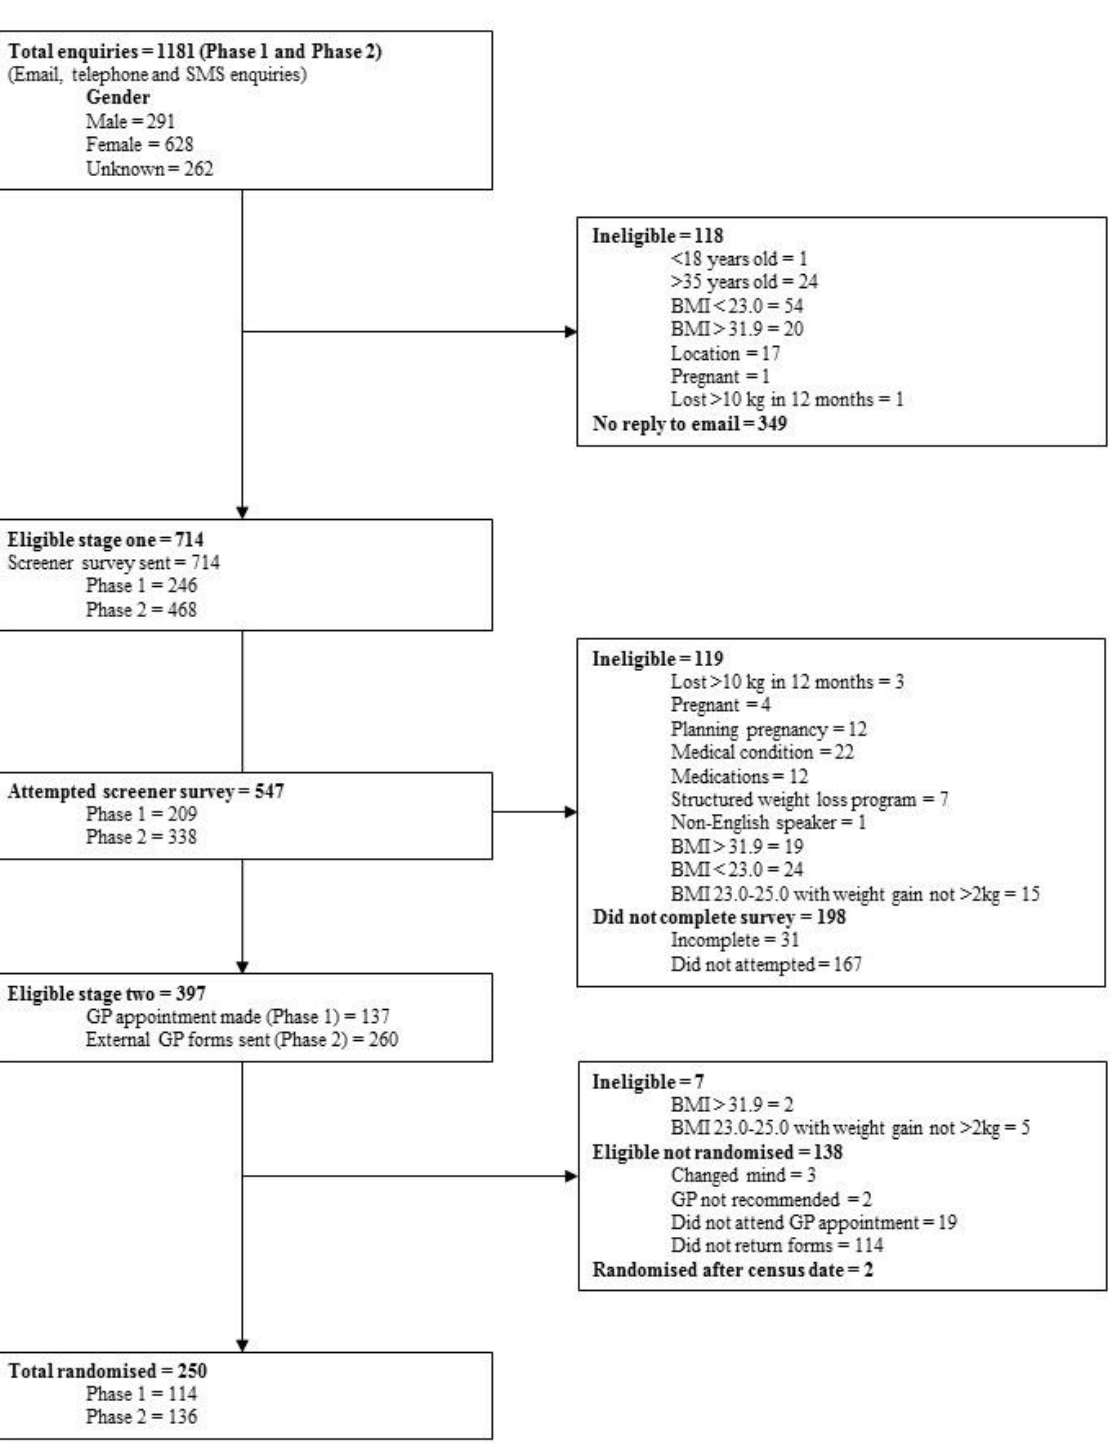
Figure 2. Flow diagram for recruitment of participants into the TXT2BFiT